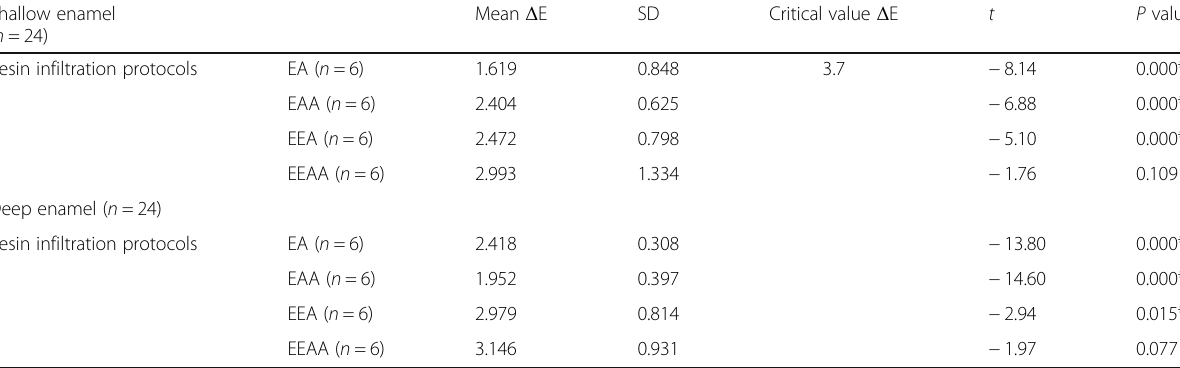
Table 2 Comparison between the mean Δ E (T2-T0) following various resin infiltration protocols of the WSLs in enamel and the threshold of clinical detection Shallow enamel ( n =